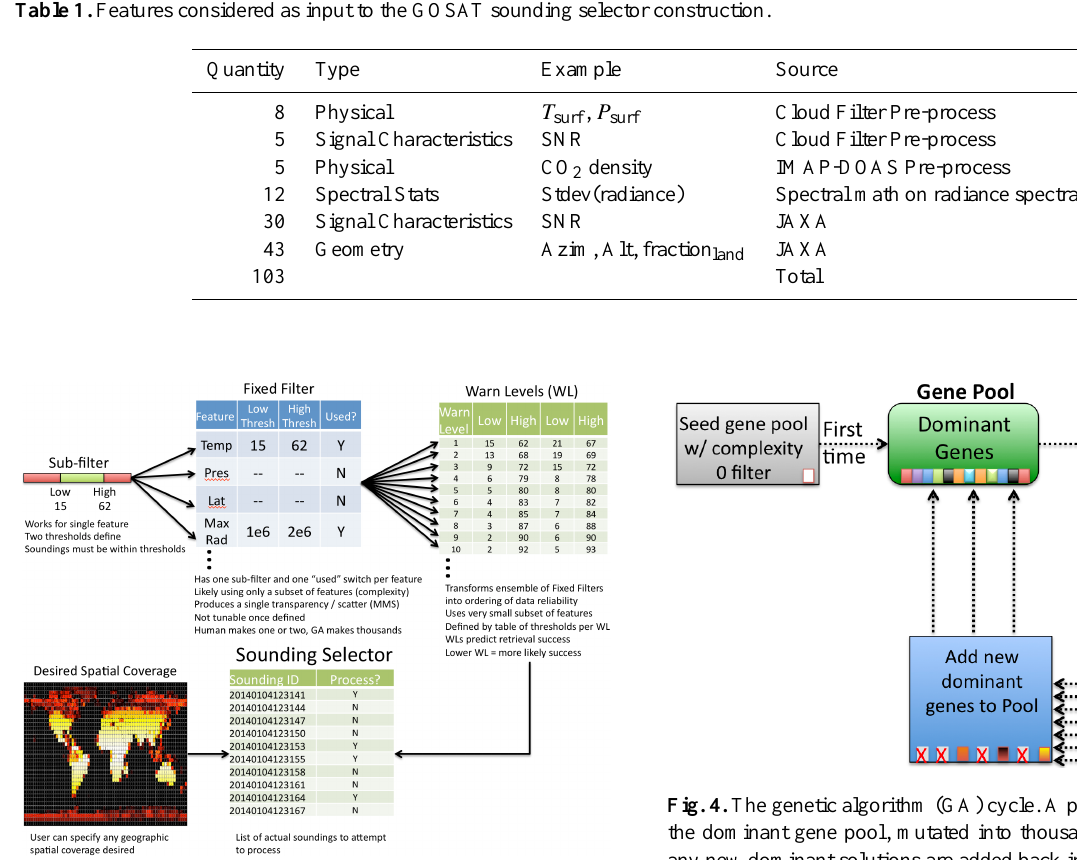
Figure 3. A guiding diagram for the discussion of filters and the final sounding selector. Note 2 Fig. 3. A guiding diagram for the discussion of filters and the final that the double “Low, High” thresholds in the upper right table show that each of the Warn 3 sounding selector. Note that the double “Low, High” thresholds in Levels is crafted from the combination of more than one Fixed Filter (in this example, two). 4 the upper right table show that each of the Warn Levels is crafted Thus, two low and two high thresholds will be required given two input features. The 5 from the combination of more than one Fixed Filter (in this exam- colorscale in the Desired Spatial Coverage to the lower left indicates the user-specified 6 ple, two). Thus, two low and two high thresholds will be required sounding density in each bin. 7 given two input features. The color scale in the Desired Spatial Cov- erage to the lower left indicates the user-specified sounding density in each bin.